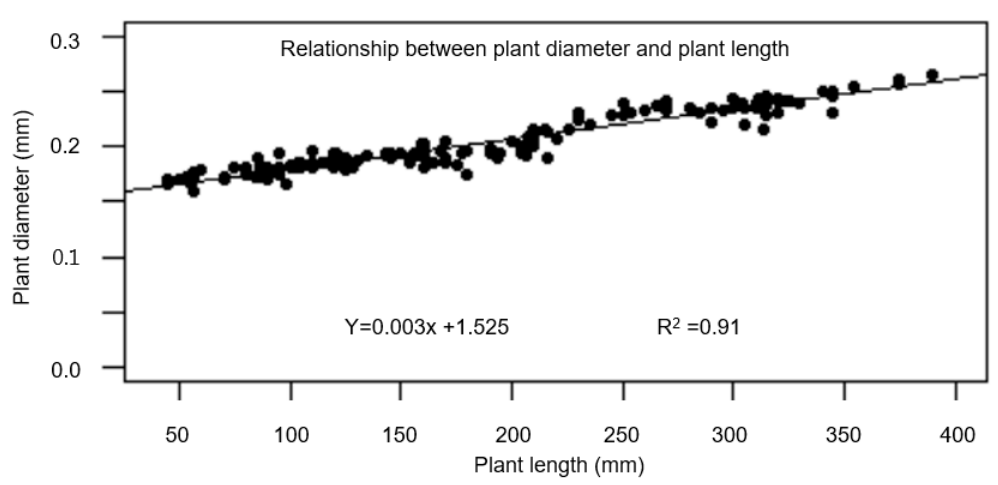
Figure 12. The relationship between plant diameters (mm) of E. repens and plant lengths (mm).